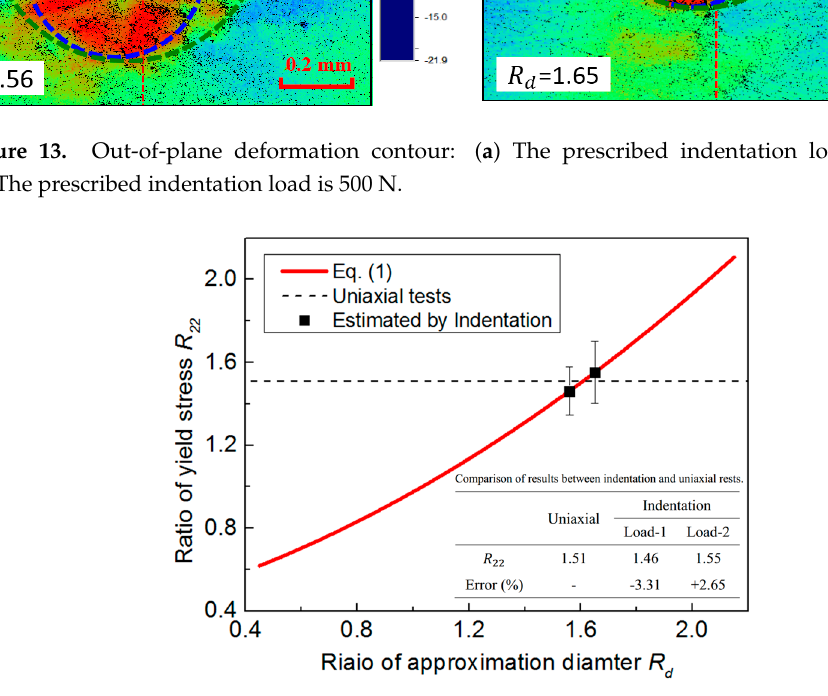
Figure 14. Comparison of the estimated (cid:1844) (cid:2870)(cid:2870) value between indentation and uniaxial tests.